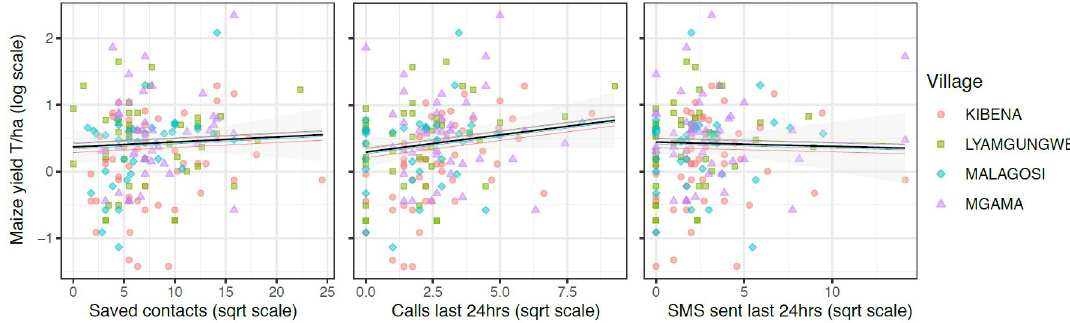
Fig 2. General phone use model estimates for the predicted association between reported maize yield outcomes and 3 phone use predictors (RQ2). Coefficient estimates of phone contacts (left), calls in the last 24 hours (center), and SMS sent in the last 24 hours (right) have mixed associations with the self-reported maize yield outcome, after controlling for individual-level wealth, gender, farm size, age, and education. The model is estimated with varying intercept effects at the household and village levels; village intercepts are plotted as colored lines in colors corresponding to village data points. Coefficients are plotted separately as predictions with 95% confidence intervals, with other fixed effect variables held at mean or modal values, and with averaging over uncertainty estimated across the model. See Table 4 for model